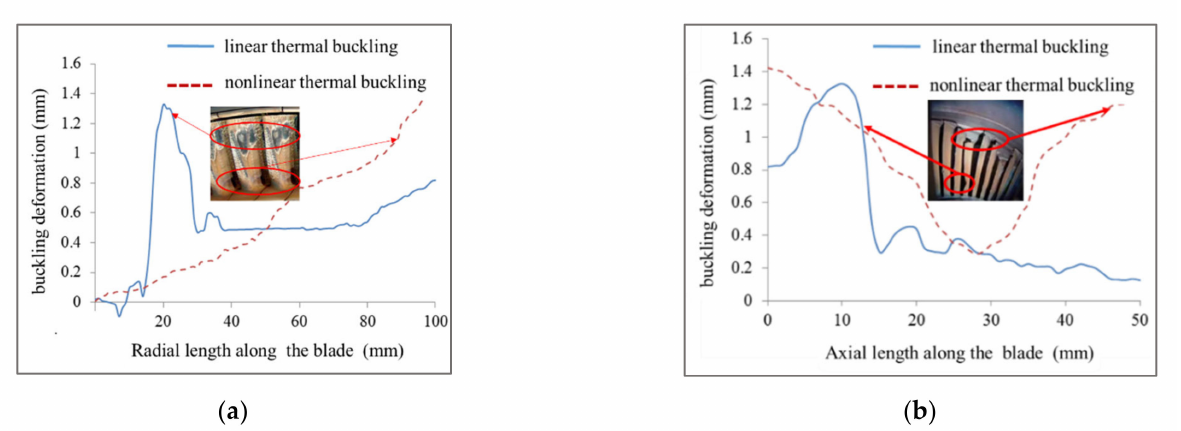
Figure 14. The radial distribution buckling deformation along the blade. ( a ) The radial distribution along the blade; ( b ) the axial distribution along the